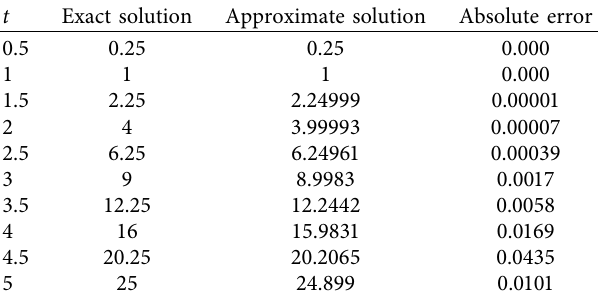
Table 2: The absolute error of ϑ ( t ) for different values of t . t Exact solution Approximate solution Absolute